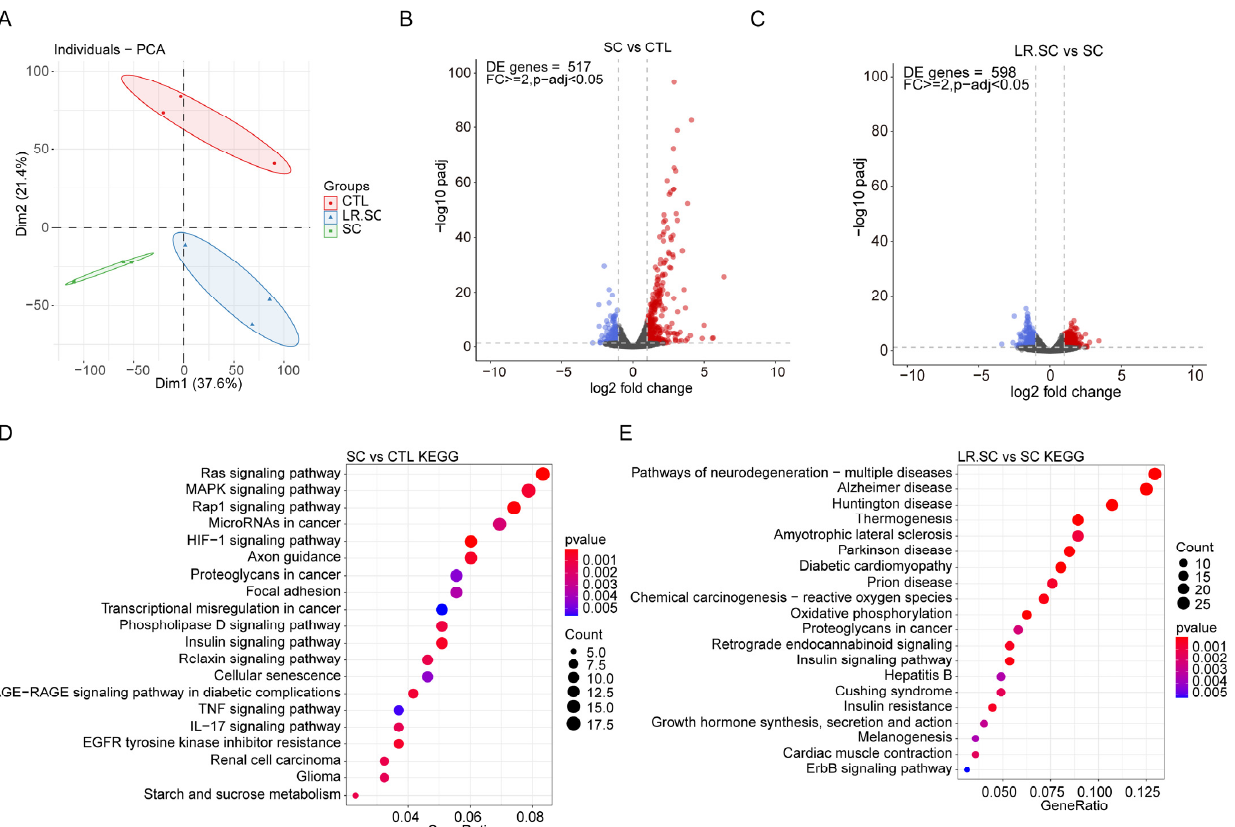
Figure 2. Quality metrics of RNA-seq data. ( A ). Principal component analysis (PCA) of all RNA-seq samples. ( B , D ). Volcano plot and top 20 signaling pathways of DEGs between S. enterica BNCC186354 and control groups. ( C , E ). Volcano plot and top 20 signaling pathways of all DEGs between S. enterica BNCC186354 groups with and without L. reuteri ATCC 53,608 treatment. The threshold was set as fold-change ≥ 2 and adjusted p -value < 0.05. CTL: control group, SC: S. enterica BNCC186354 treatment group, LR.SC: L. reuteri ATCC 53,608 and S. enterica BNCC186354 treatment group (the same below).